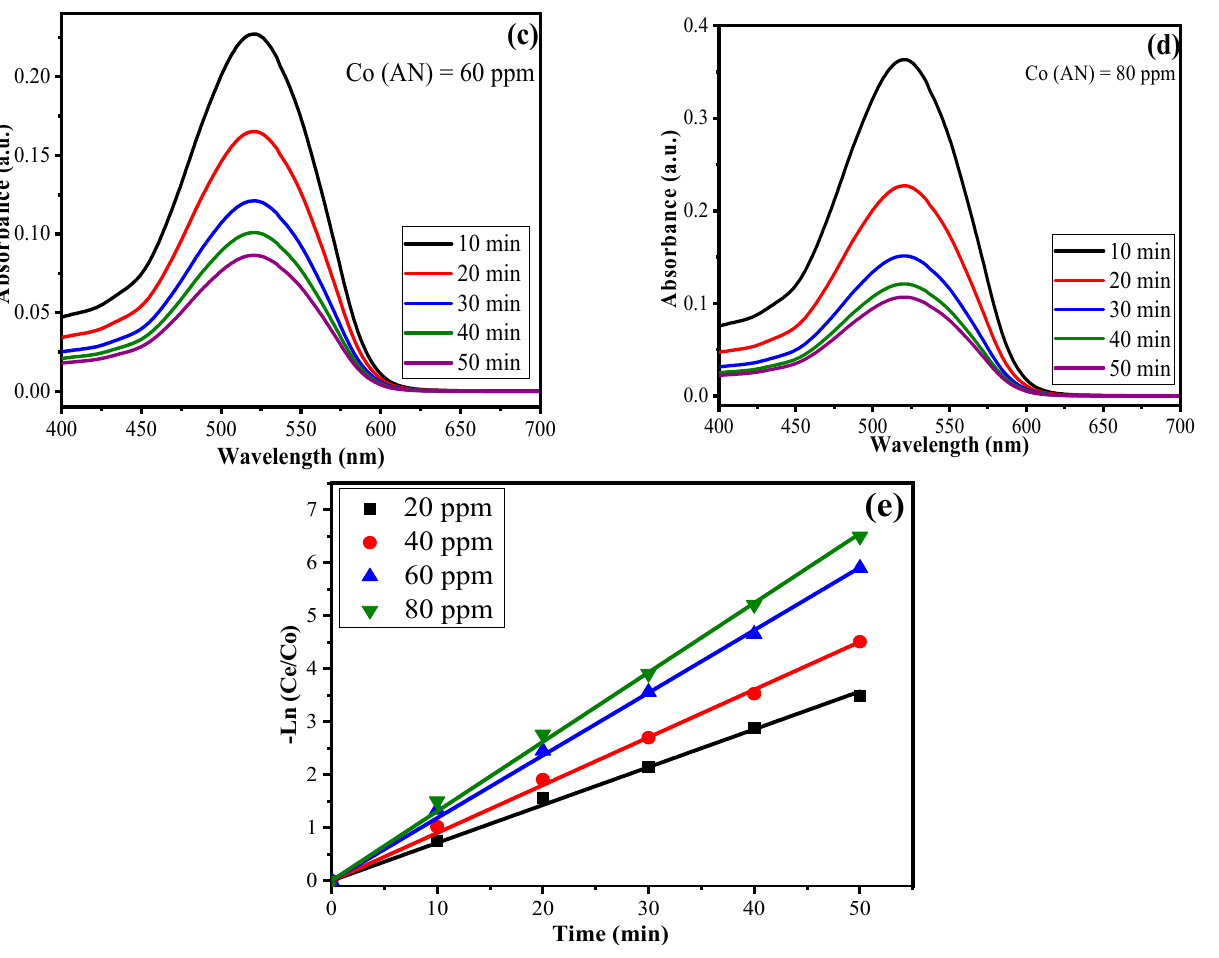
Figure 9. UV-Vis absorption spectra of AN at ( a ) 20 ppm, ( b ) 40 ppm, ( c ) 60 ppm, ( d ) 80 ppm under range of irradiation time 10–50 min at pH at 4 and ( e ) linear regression plot for pseudo first order kinetics. Table 4. Kinetic parameters and their values for pseudo first order kinetic model proposed by Lang- muir–Hinshelwood for degradation of AN by synthesized material.